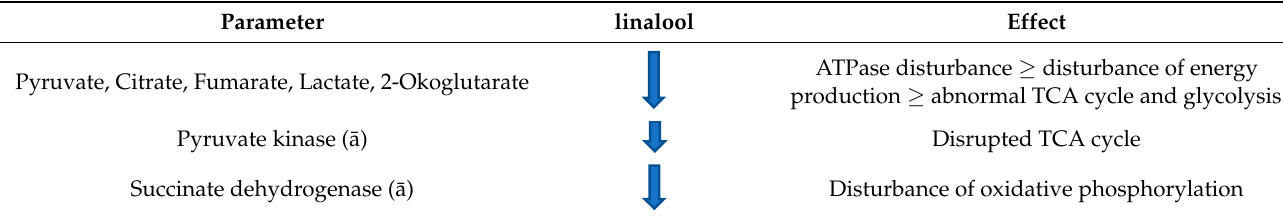
Table 4. Effect of linalool on carbohydrate metabolism. Table 3. Effect of linalool on amino acid metabolism.